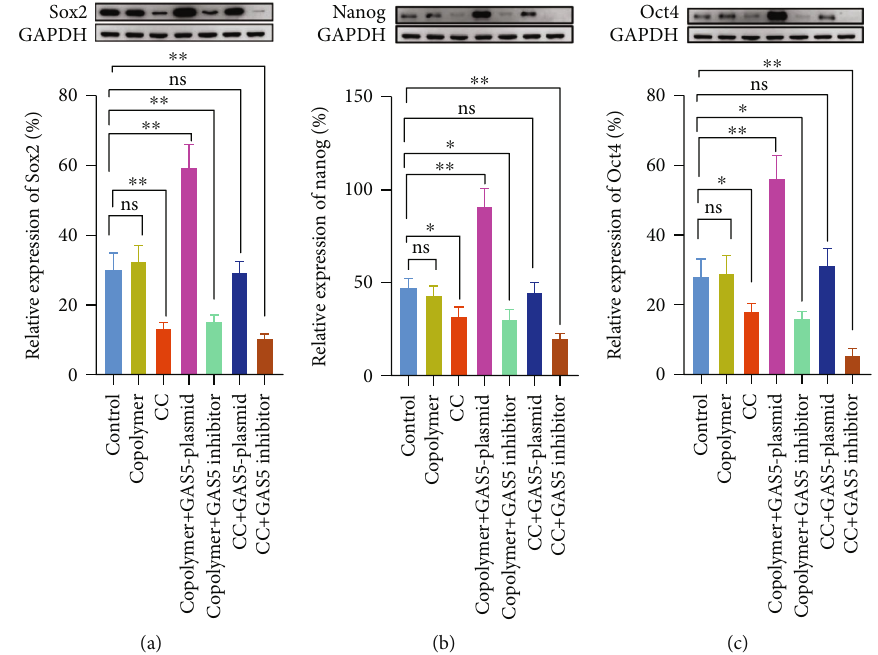
Figure 3: Low-expressed lncRNA GAS5 promotes the expression of stem cell markers. (a – c) The expression of stem cell markers Sox2 (a), Nanog (b), and Oct4 (c) at the cellular level ( ∗ P < 0 : 05 , ∗∗ P < 0 : 01 , and ∗∗∗ P < 0 : 001 ; ns: not signi fi cant).